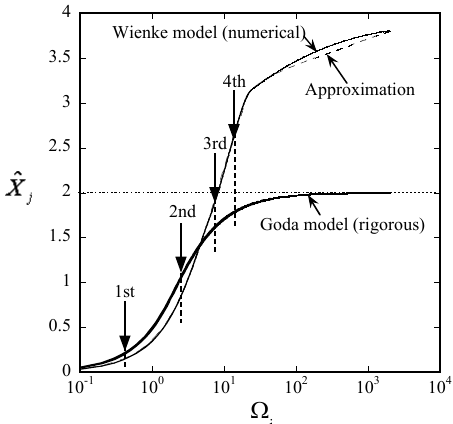
Impulse response factor for a circular